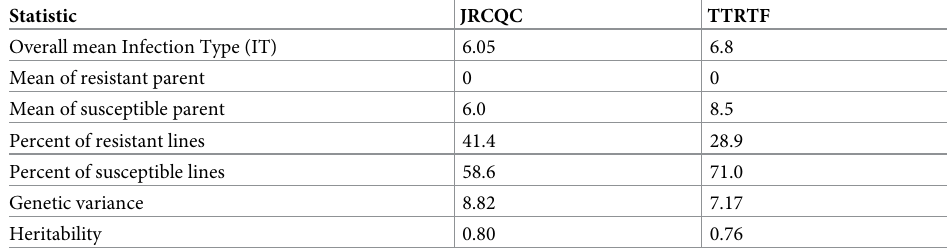
Table 1. Mean, genetic variance and broad-sense heritability of seedling infection response of the RIL population against races JRCQC and